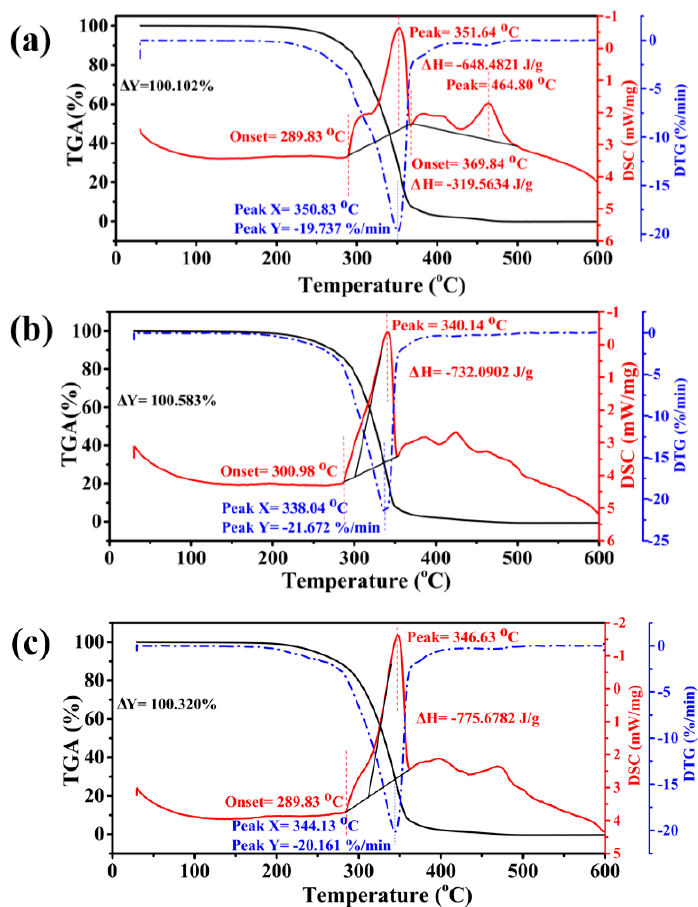
Figure 11. TGA − DSC − DTG curves of ( a ) pure synthetic ester, ( b ) SE/CdS, ( c ) and SE/Co 3 O 4 at a heating rate of 10 °C/min in air.